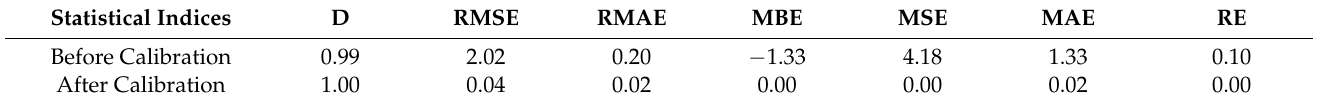
Figure 11. Calibration results for the lysimeter before plantation of the chrysanthemum crop. Table 3. Descriptions of statistical analysis in the calibration process of the